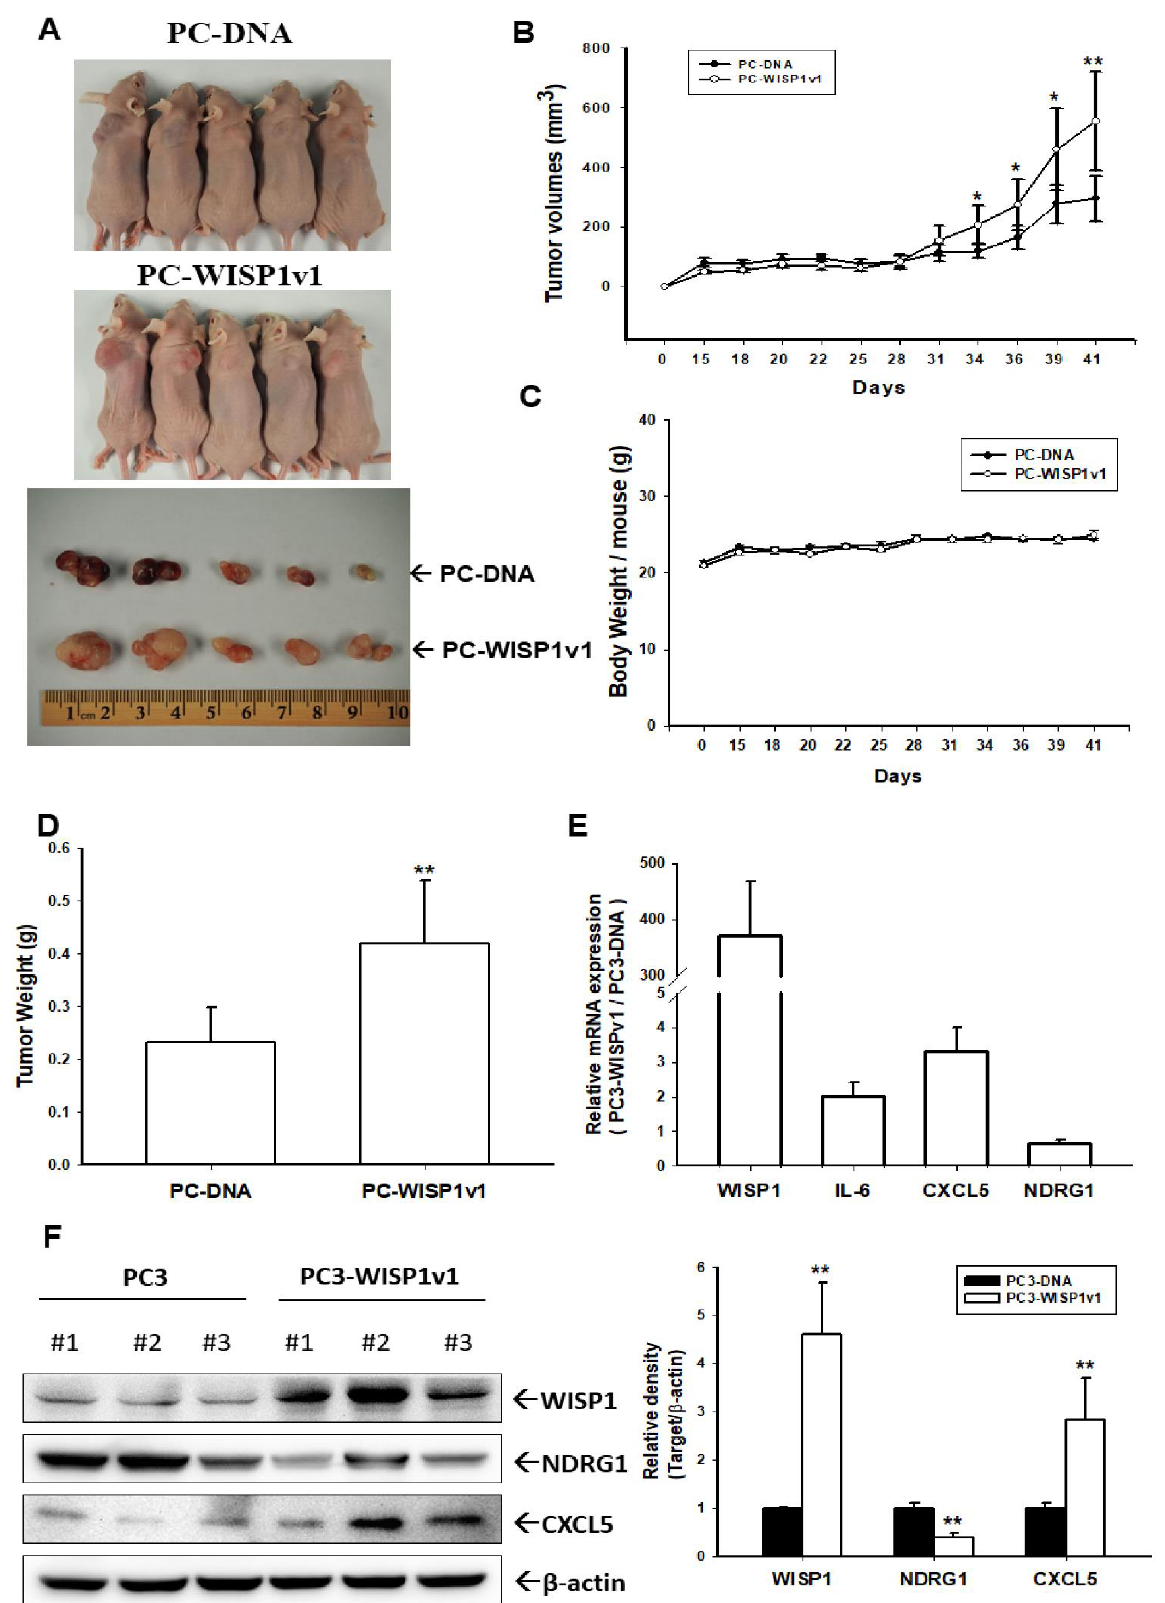
Figure 6. Modulating effect of WISP1v1 on the tumor growth of prostate carcinoma PC-3 cells. ( A , top) PC-DNA and PC-WISP1v1 cells were injected subcutaneously in the dorsal area of the